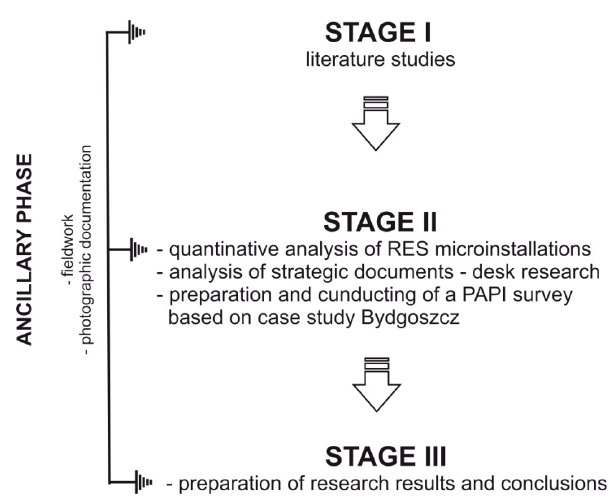
Figure 1. General research procedure framework. Source: own study.